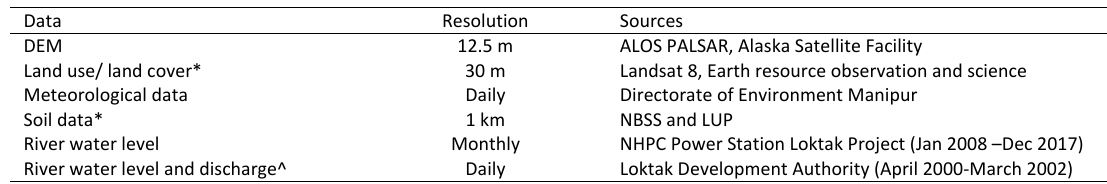
Table 1: Input data and source